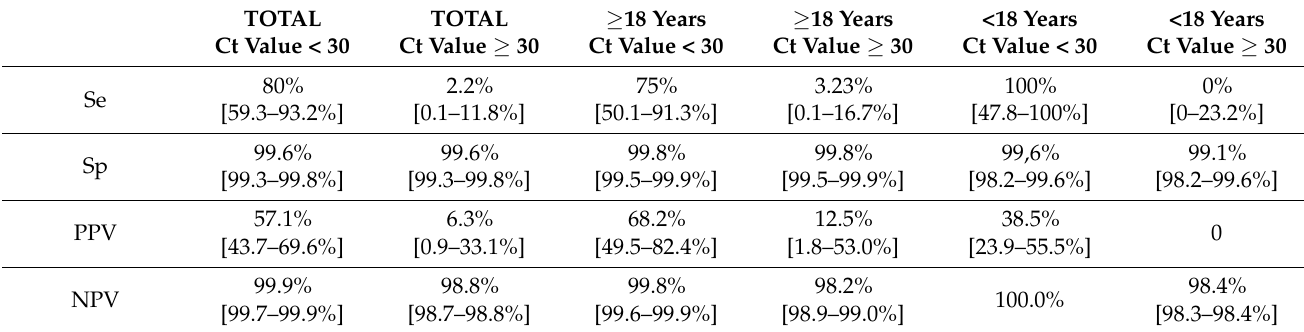
Table 4. Performance of the rapid antigen test depending on the N-gene Ct